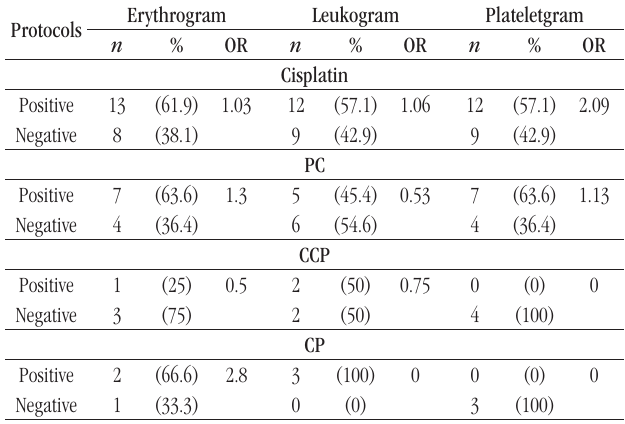
table 2 – Analysis of complete blood count results, Caruaru, Pernambuco, 2018 table 3 – RR of using the various protocols × hematological changes, Caruaru,